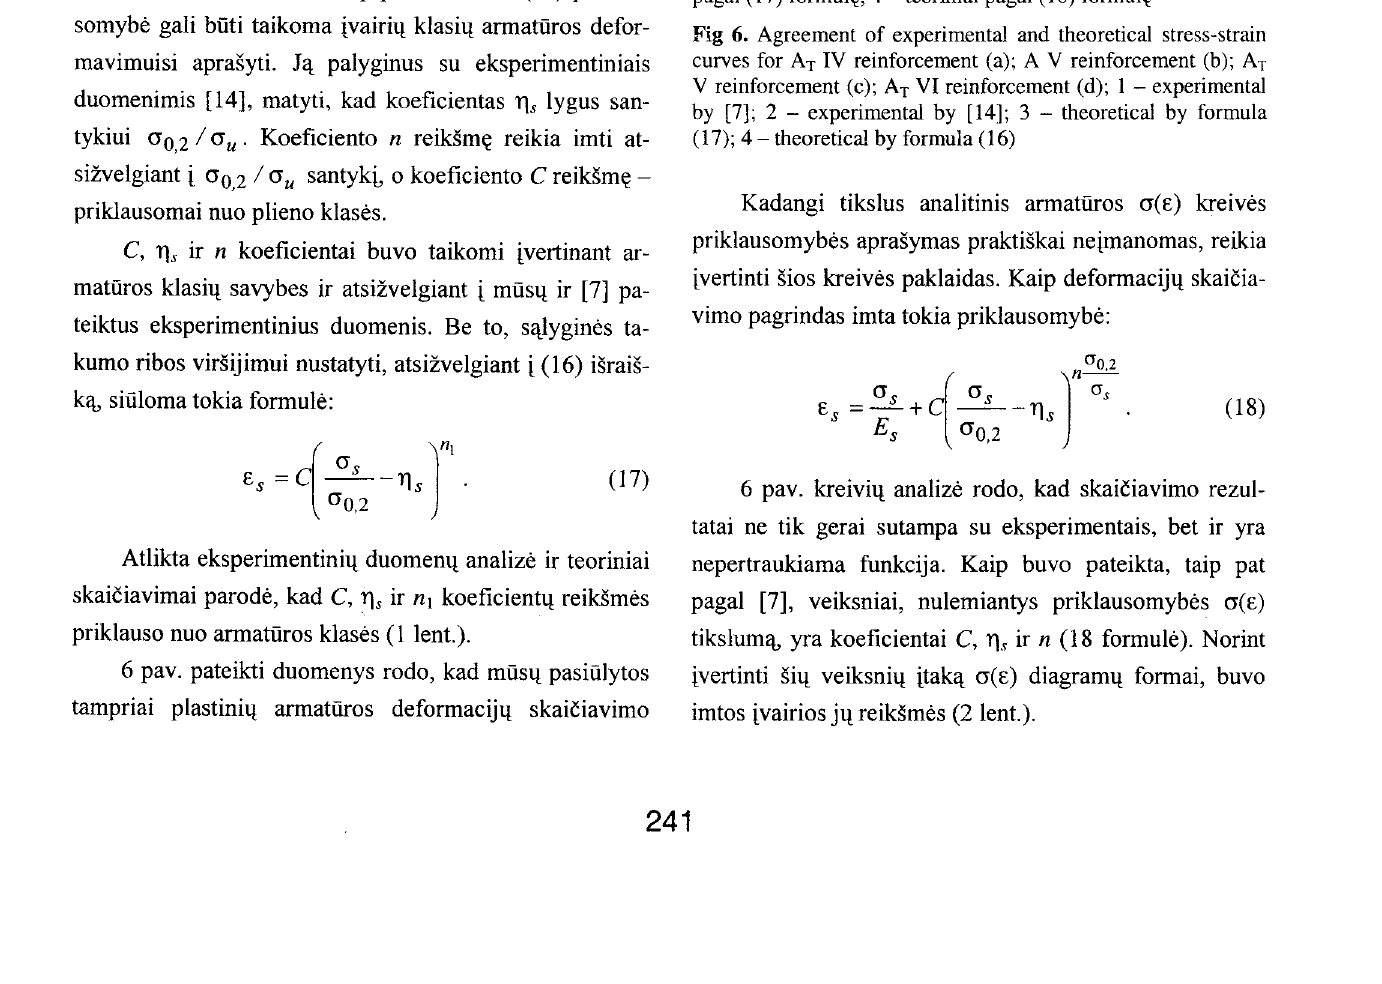
Fig 6. Agreement of experimental and theoretical stress-strain curves for AT IV reinforcement (a); A V reinforcement (b); AT V reinforcement (c); AT VI reinforcement (d); I